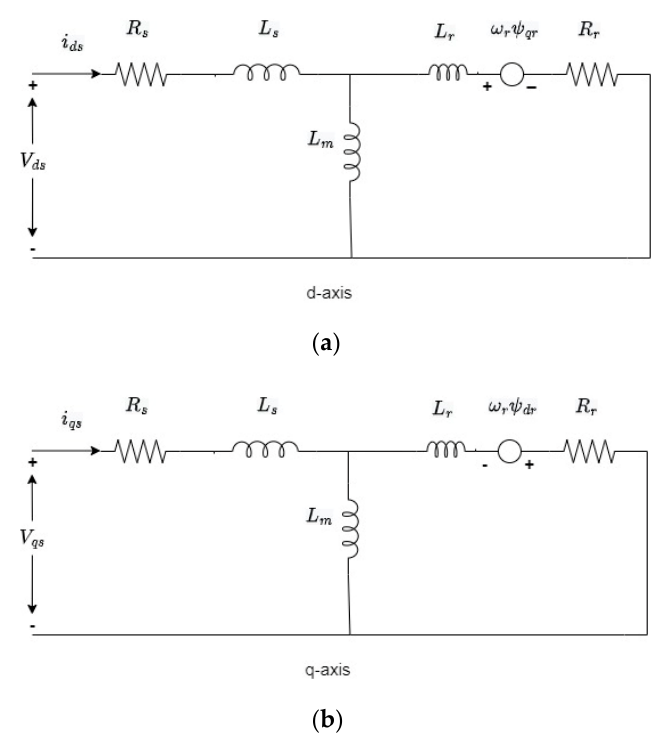
Figure 1. Axes of three − phase induction motor: ( a ) Direct, ( b ) Quadrature.